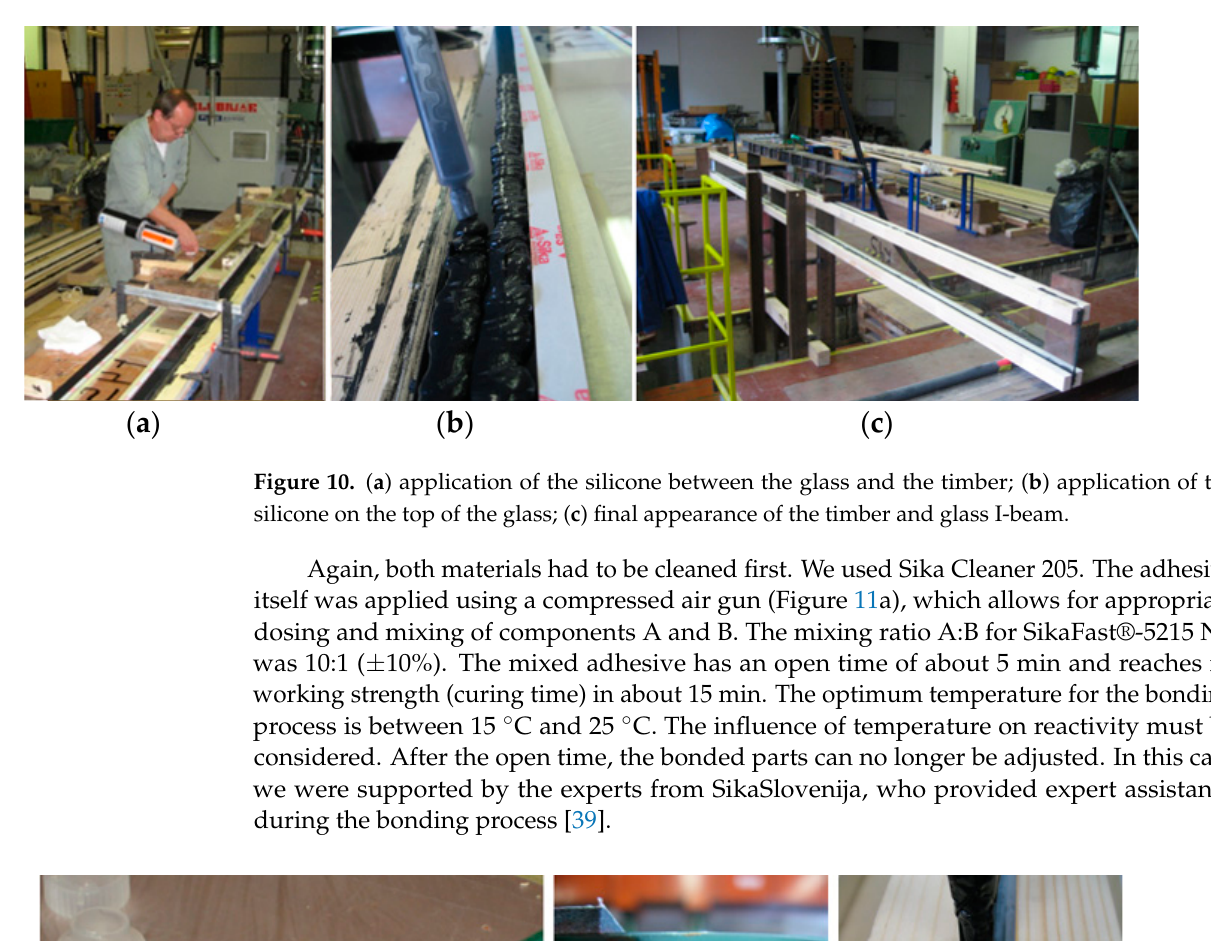
Figure 10. ( a ) application of the silicone between the glass and the timber; ( b ) application of the silicone on the top of the glass; ( c ) final appearance of the timber and glass I-beam. Acrylate